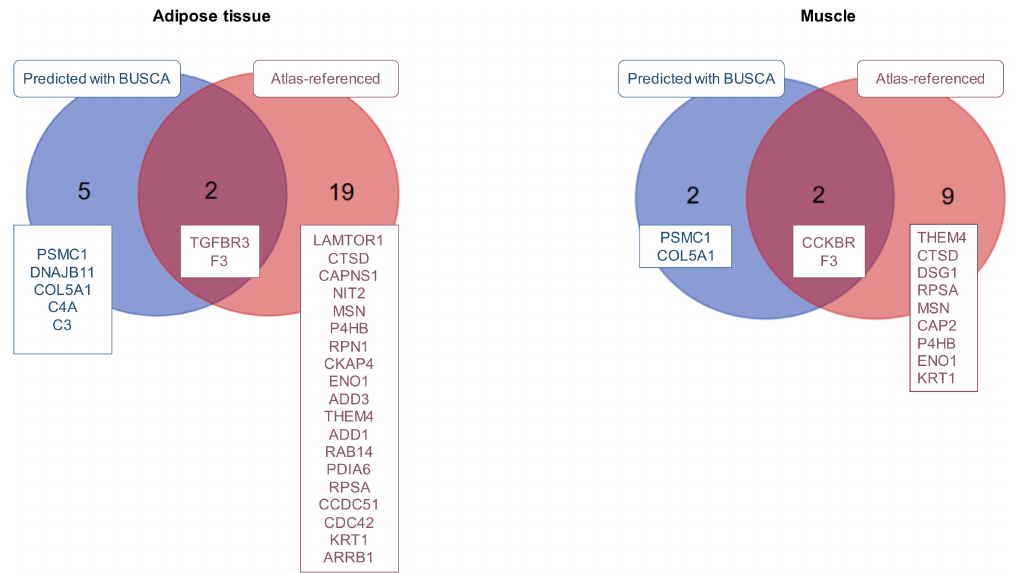
Figure 3. Proteins proposed to be present at the cell surface, and thus to contribute to the surfaceome of bovine fetal adipose tissue and muscle. Putative cell surface proteins were identified either by prediction using the BUSCA web server or by comparison between the lists of fetal bovine proteins and the list of 5956 proteins referenced at the cell surface by merging results from [14–16] and the named surfaceome atlas. The Venn diagrams (http: // bioinformatics.psb.ugent.be / webtools / Venn / , VIB / UGent, Bioinformatics & Evolutionary Genomics, Gent, Belgium) of the fetal bovine adipose tissue and muscle proteomes show the intersection between the prediction and the comparison with the surfaceome atlas.